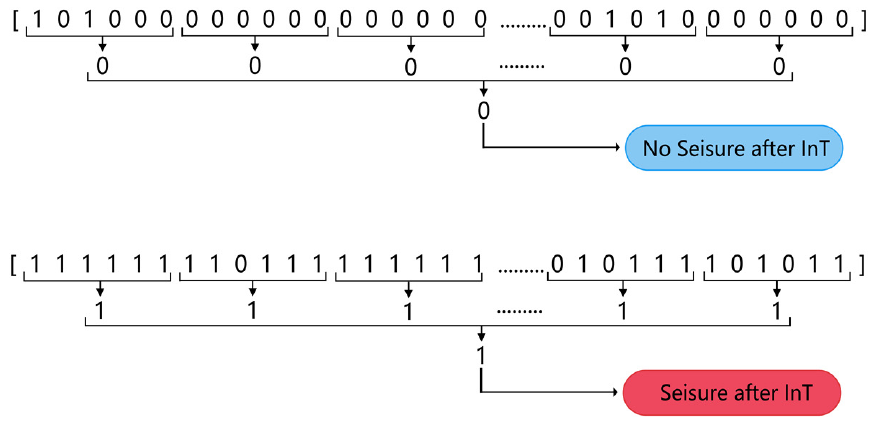
Figure 5. Two-step “k of n” post-processing.